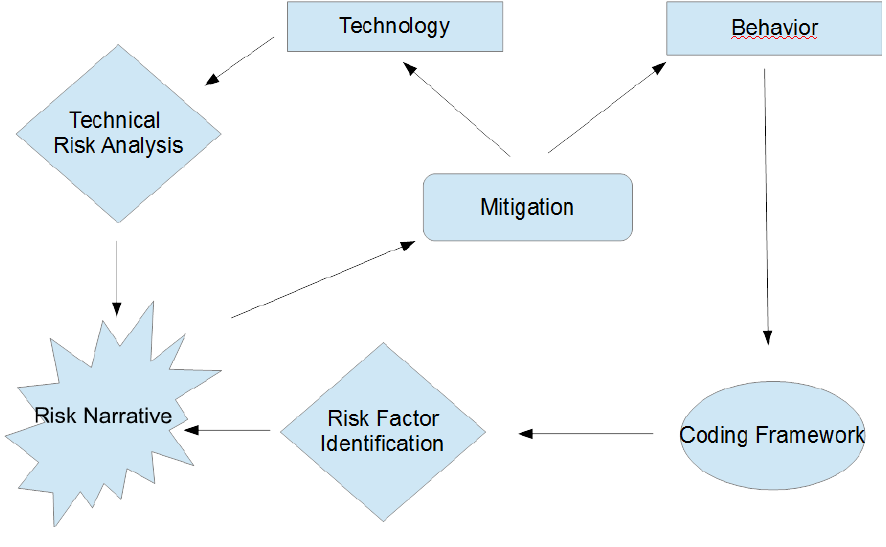
Figure 5. Overall Risk Analysis